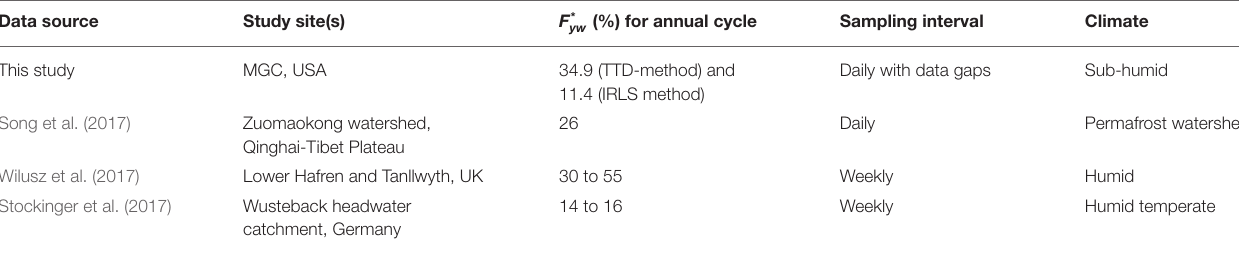
TABLE 2 | Representative F * yw estimates based on the TTD method from the literature including the current